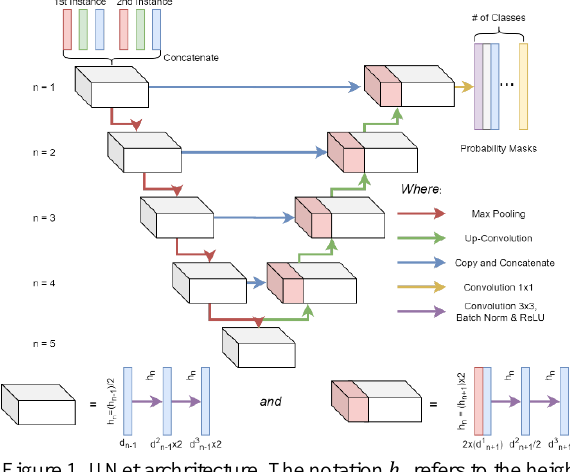
Figure 1. UNet archritecture. The notation ℎ 𝑛 refers to the height of the convolutional layers at block level 𝑛 and 𝑑 𝑛𝑖 refers to the number of channels of the 𝑖 𝑡ℎ convolutional layer in level 𝑛 .The width of each convolutional layer has an identical behavior as the height and for this reason it has been omitted. We can see that the channel depth of a convolutional layer at layer n is twice as large as the corresponding depth of the corresponding convolutional layer of block level